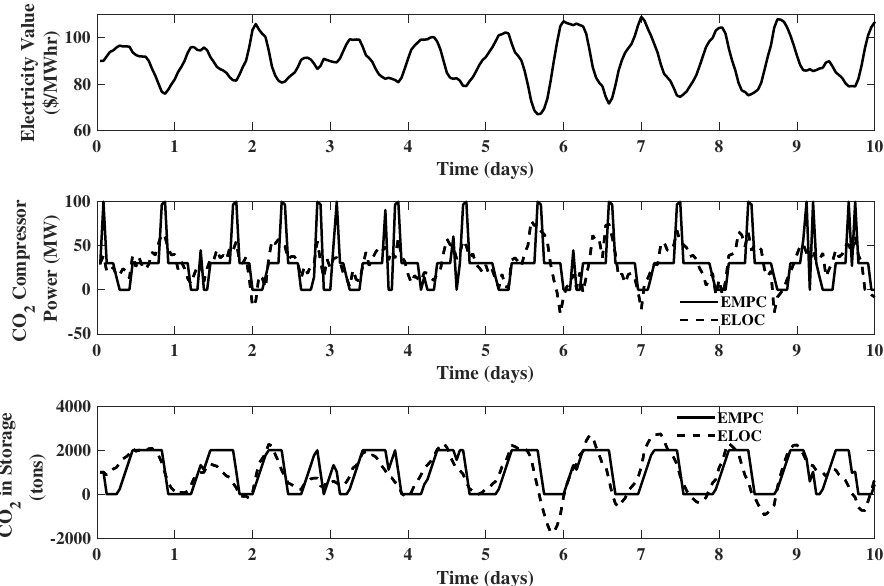
Figure 13. Comparison of EMPC and ELOC policy for Example 9: carbon dioxide compressor power consumption and carbon dioxide